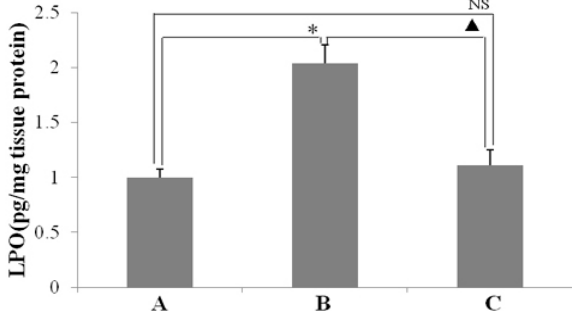
Figure 4. The effect of resveratrol on lipid peroxide (LPO) level (pg/mg protein) in the gastric mucosal tissues of mice infected by H. pylori. (A) Normal control animals; (B) H. pylori -infected model animals; and (C) H. pylori -infected animals treated with resveratrol. * p < 0.05 versus normal animals; ▲ p < 0.05 versus model animals; NS: no significant differences versus normal animals ( n = 10).